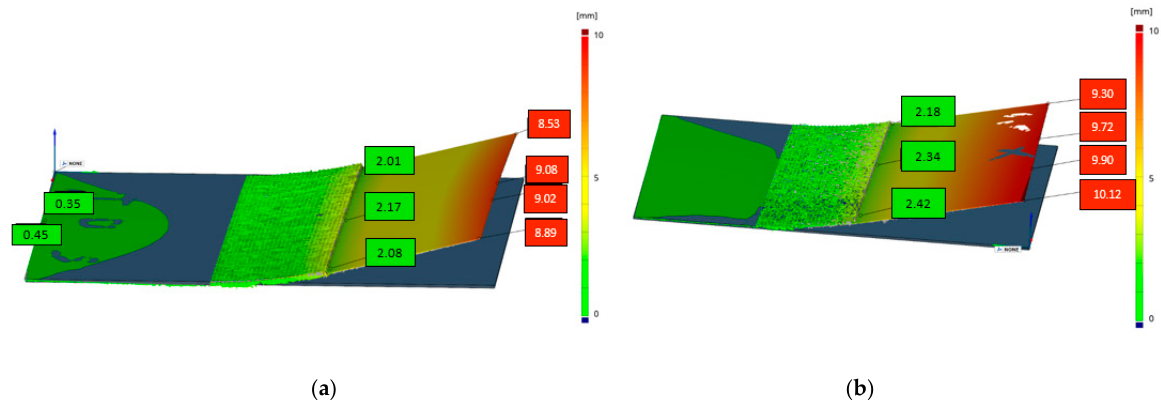
Figure 9. Optical 3D scanning images for warpage measurement (distance s [mm]): ( a ) The scanning strategy Contour-CLI showed lower maximum warpage with 2.17 mm than ( b ) Cross-CLI with 2.42 mm.